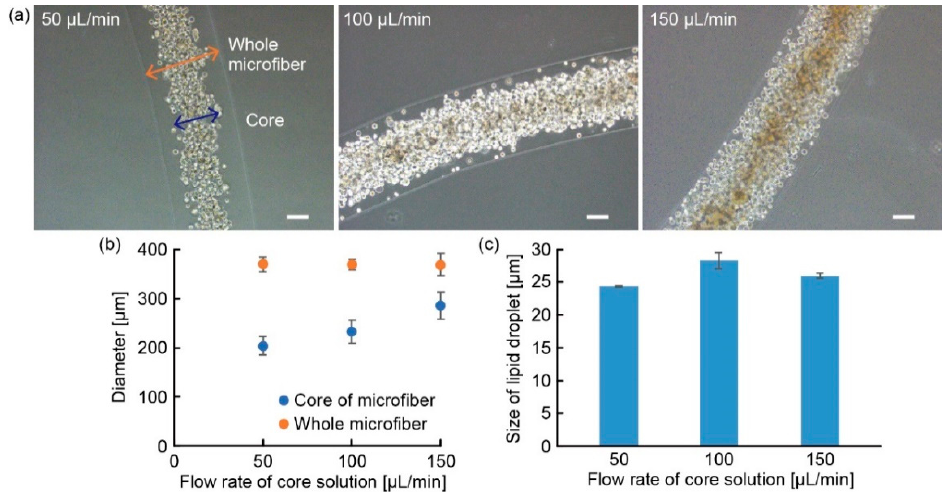
Figure 6. Relationship between flow rate of core solution and size of lipid droplets in adipocytes: ( a ) Images of adipocyte-laden hydrogel microfibers (the flow rate of core solution was 50 µL/min, 100 µL/min, 150 µL/min); ( b ) Relationship between diameters of the microfibers and flow rates of core solution under 300 µL/min flow of shell solution (N ≥ 5, mean ± s. e. m.); ( c ) Size of lipid droplets after 21 days of culture depending on the flow rate of the core solution (N = 3, mean ± s. e. m.). Scale bars are 100 µm.